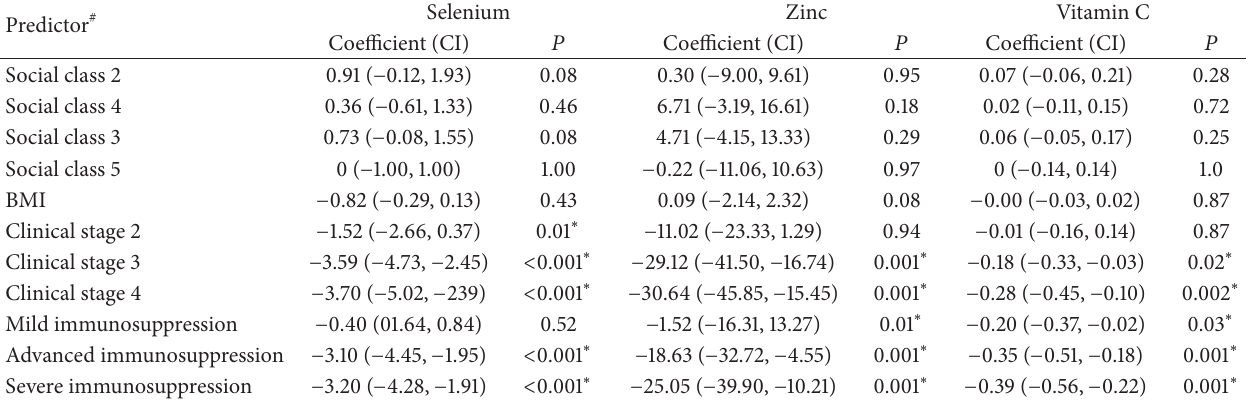
Table 4: Predictors of serum selenium, zinc, and vitamin C in HIV infected